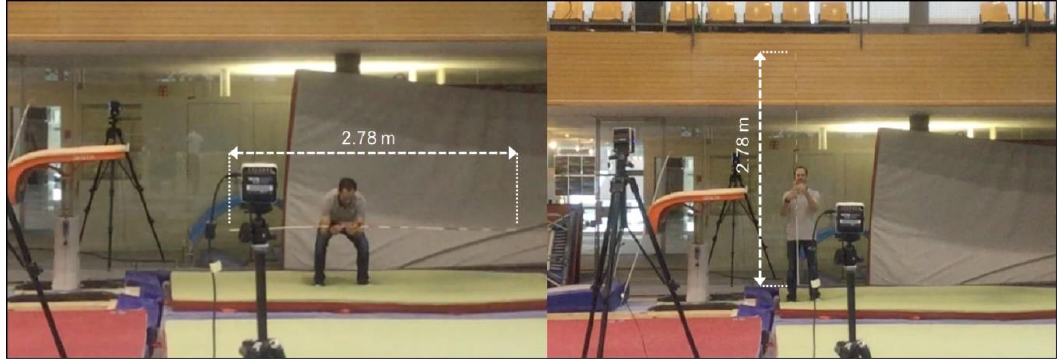
Figure 1. 2D calibration: calibration of measuring range by definition of reference height and width with the calibration rod (2.78 m) in the 2D-video software Dartfish (Dartfish SA, Fribourg, CH).